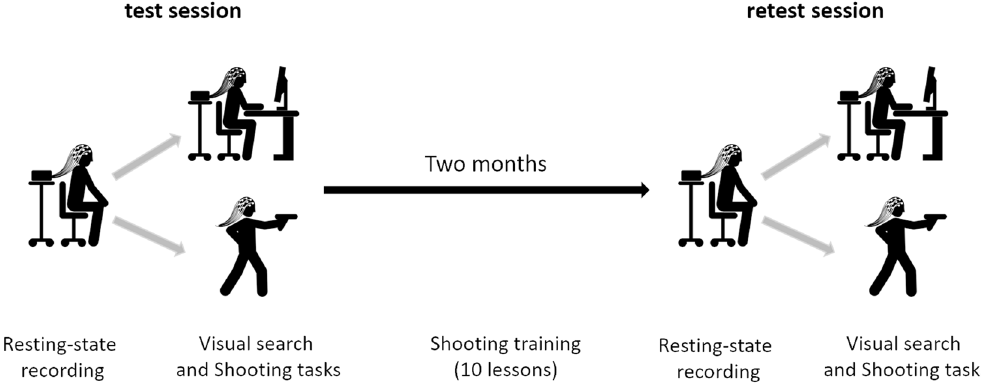
Figure 8. Scheme of the experiment. The experiment started with a test session comprised of an eyes open resting-state EEG recording (64 channels) preceding the visual search (64 channels) and shooting task (32 channels – wireless). After approximately two months, all tasks and recordings were repeated in a retest session. Between sessions all participants received 10 lessons of gun